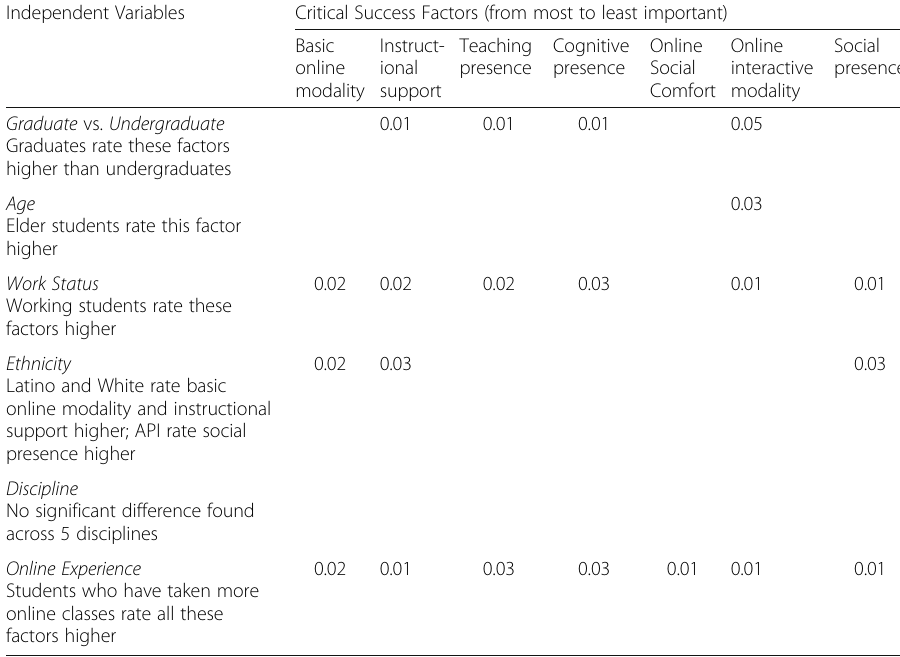
Table 4 Eta Squared Values for Significant ANOVAs Independent